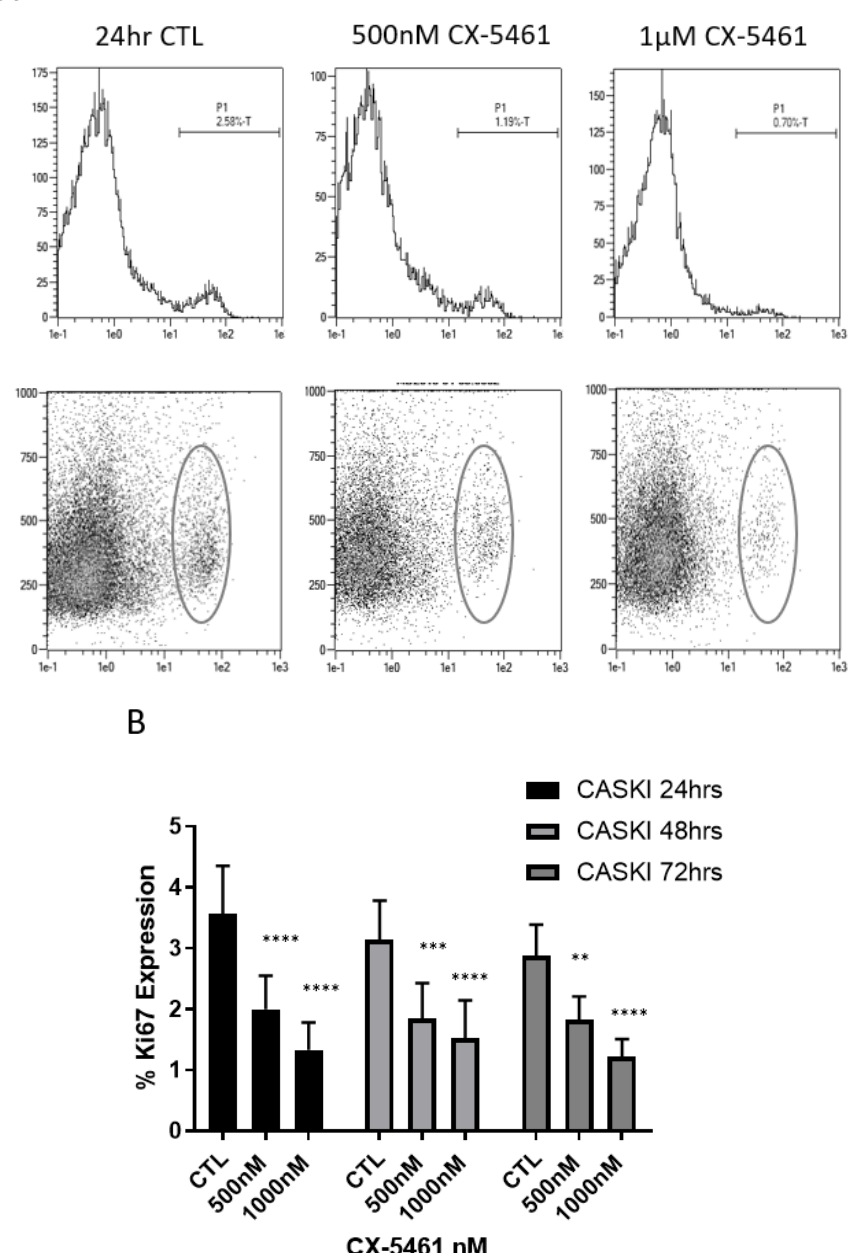
Figure 3. CX-5461 as an anti-proliferative agent. Flow cytometry histogram analysis of CaSki Figure 3. A and B